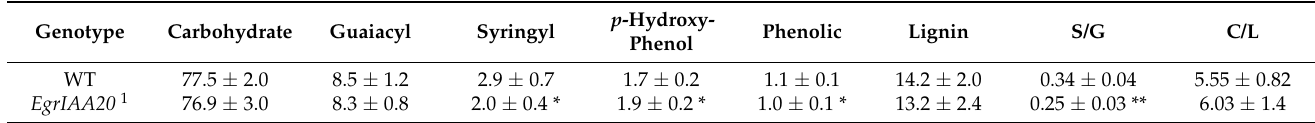
Table 1. Chemical composition of wild type and EgrIAA20_OE transgenic Arabidopsis hypocotyls by Py-GC/MS analysis (n > 12).